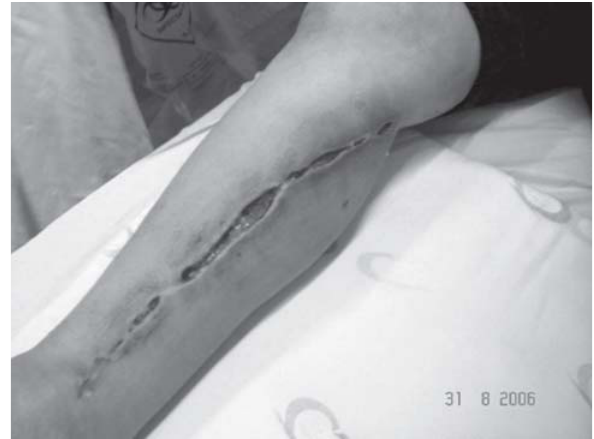
Fig. 2 - Deiscência da safectomia: após dois dias da 1ª aplicação do LBI